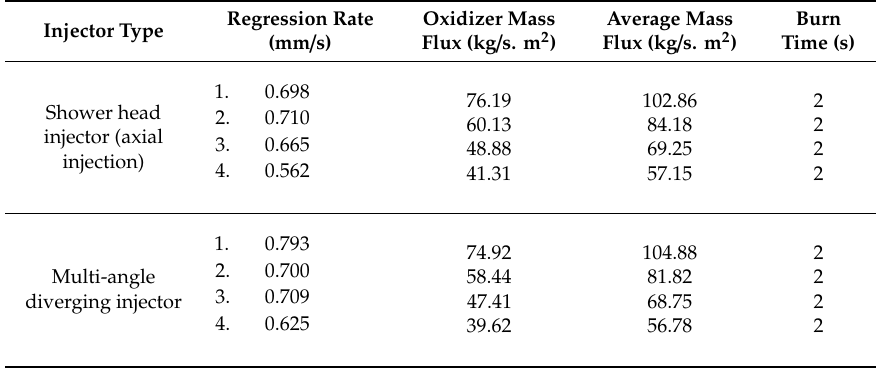
Table A1. Interrupted test firings for PVC fuel.